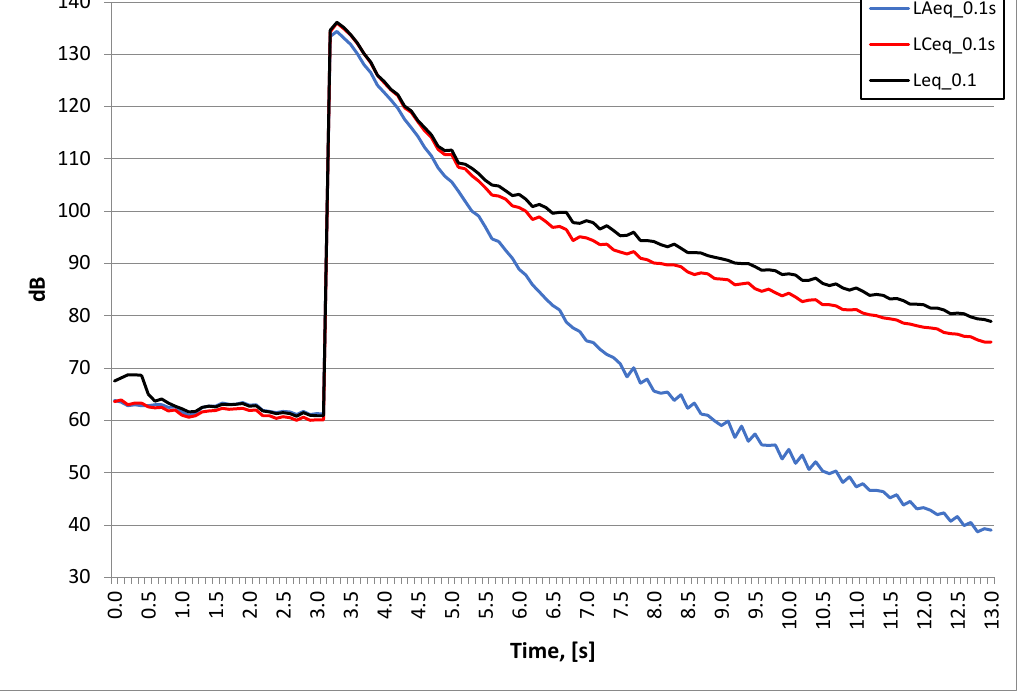
Figure 11. Test No. II: sound pressure level pyrotechnic material explosion; stand 5.